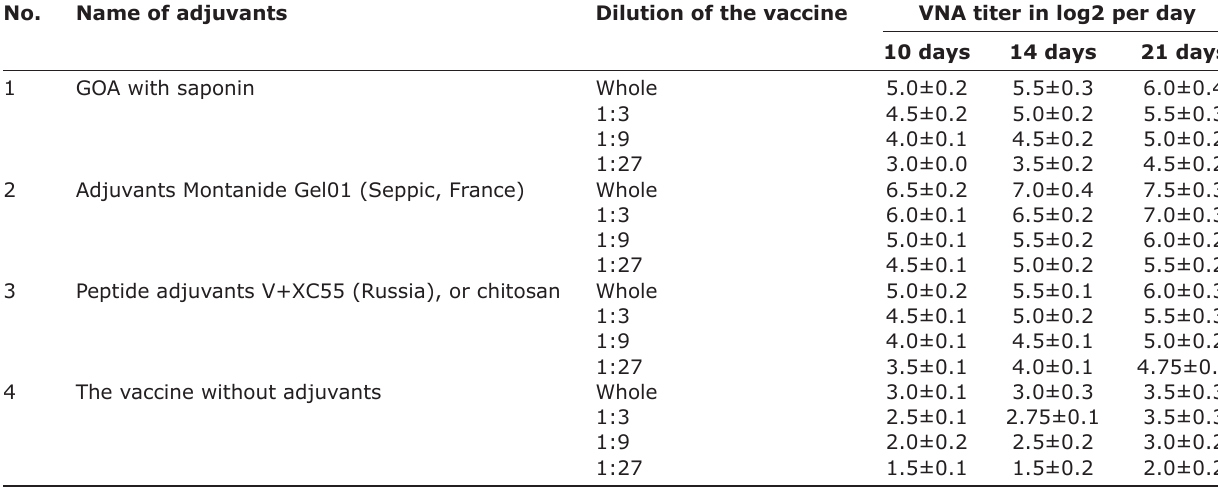
Table-1: VNA titer level in animals vaccinated with adjuvant vaccine. No.